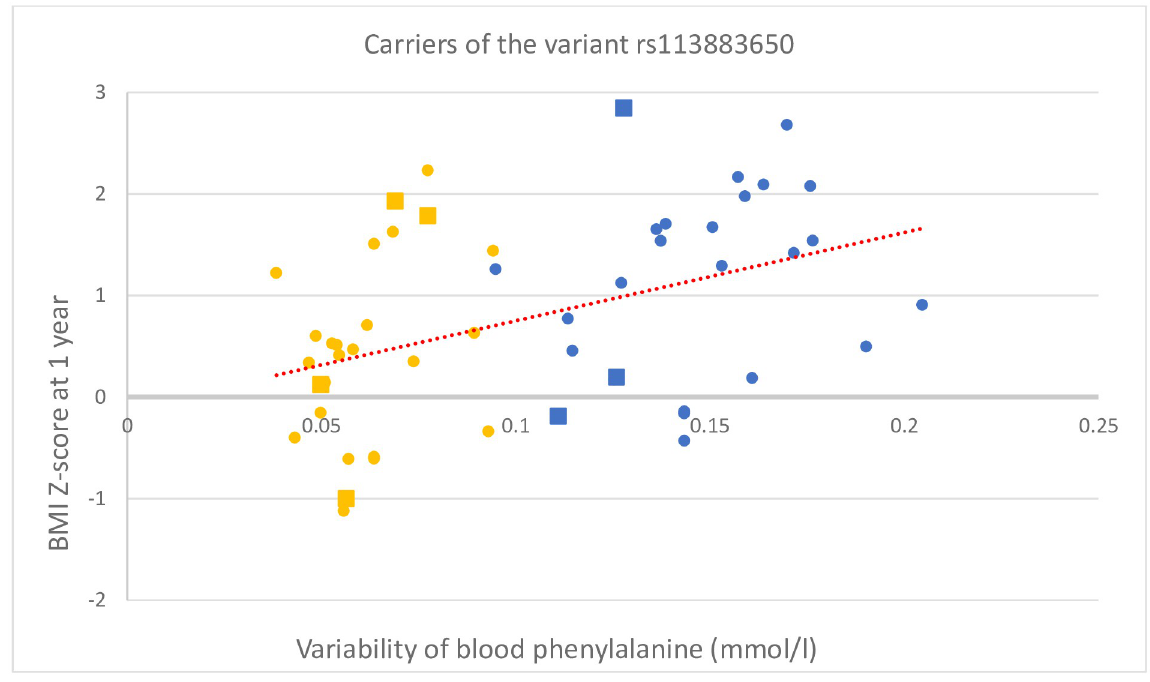
Fig 2. The relation of BMI Z-scores at one year and the variability of blood phenylalanine levels in the first year of life for infants with PKU and MHP—Carriers of the rs113883650 variant of the LAT1 gene. The variability of blood phenylalanine levels is represented by the SD of all blood test results recorded in the assessed period for a given patient. The BMI Z-scores and blood phenylalanine variability in carriers of the LAT1 variant were moderately positively correlated, r(42) = 0.46, p = 0.002. Patients on dietary treatment are marked in blue, whereas those not requiring diet are marked in yellow. Square markers indicate the homozygotes for the variant of the LAT1 gene.